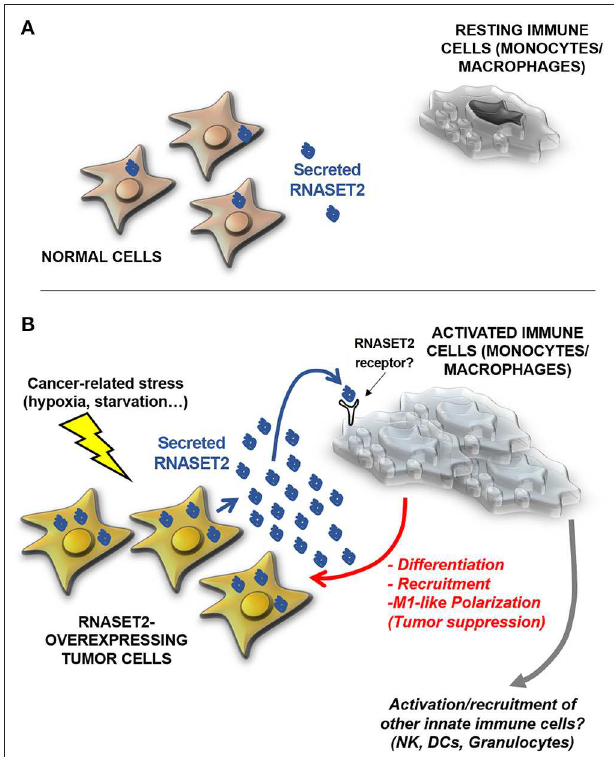
FIGURE 2 | A model for human RNASET2-mediated tumor suppression. (A) In physiological contexts, most human cells express low or undetectable RNASET2 levels (https://www.ncbi.nlm.nih.gov/gene/8635), with the notable exception of spleen, lymph nodes and colon, three tissues highly involved in immune system function. This ubiquitous “baseline” RNASET2 expression can be related to the execution of intracellular or extracellular roles (some yet-to-be defined) possibly mediated by its catalytic activity. (B) When cells are locally exposed to a wide range of stresses, some of which are typically experienced by cancer cells (such as hypoxia, oxidative stress or nutritional starvation), they activate a “danger-response” program which involves, besides the activation of several endogenous stress response pathways, a massive increase in expression and secretion of RNASET2, which acts as an alarmin-like molecule to engage cells belonging to the innate immune system (mostly macrophages, but possibly other cellular components such as natural killer (NKs), dendritic